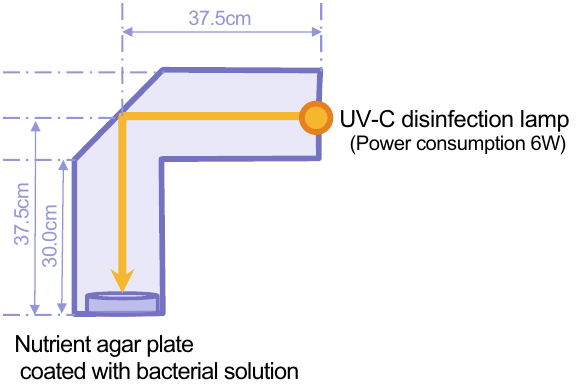
Figure 1. Test apparatus for evaluating the disinfection effects of UV-C reflected irradiation to various materials. UV-C from a UV germicidal lamp (6 W, 254 nm) was reflected in a 90° on the inner wall covered with various materials. The reflected lights were irradiated on the agar plate coated with bacteria